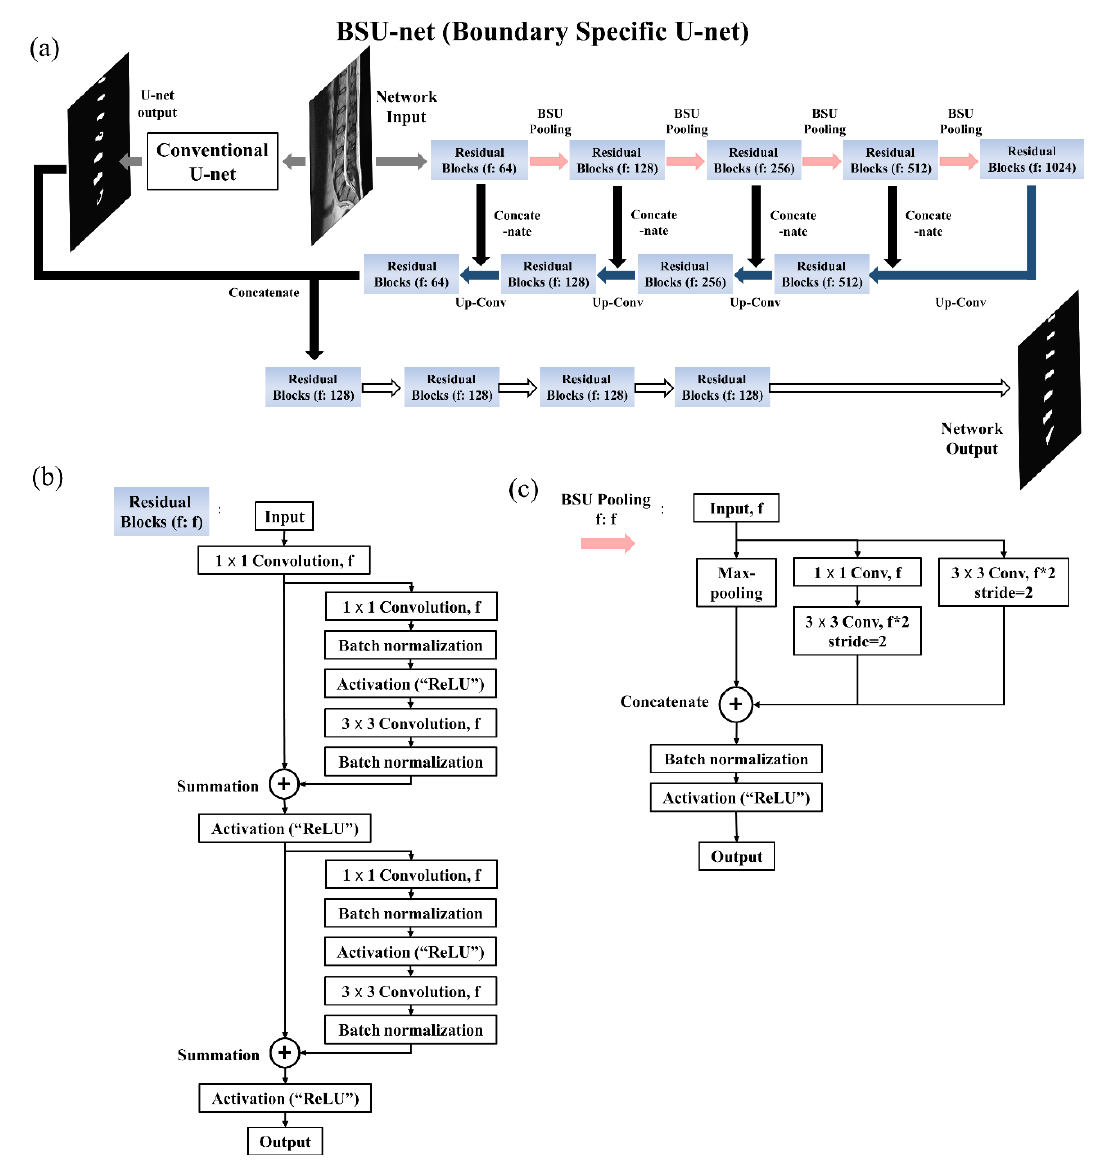
Figure 3. Whole structure of the proposed network. ( a ) Structure of the boundary specific U-network (BSU-net). ( b ) Structure of residual block. ( c ) Structure of BSU-pooling layer.